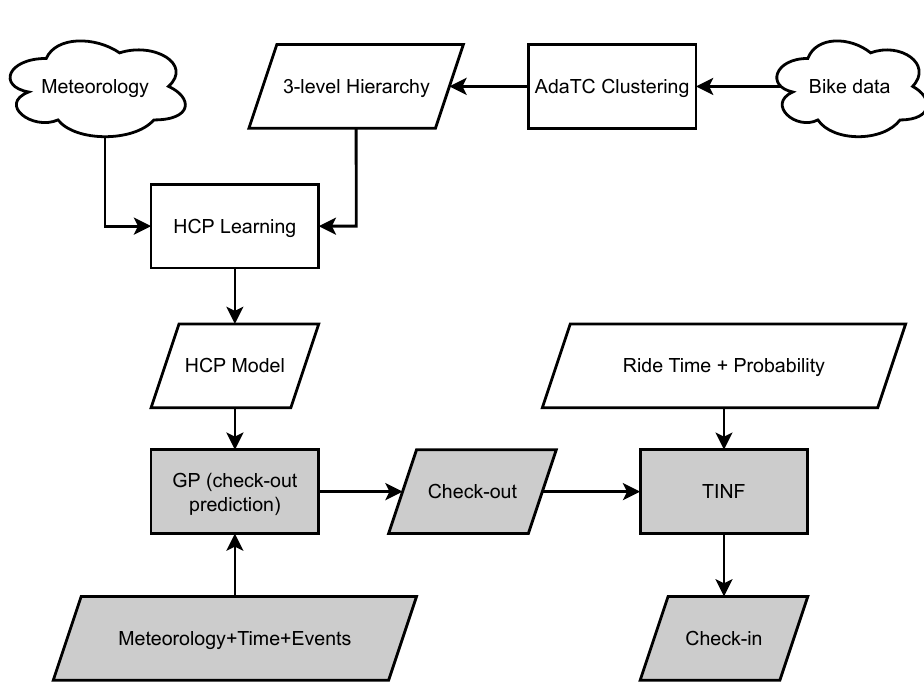
Figure 4. Prediction framework used for solving the bike-sharing system problem consists of various algorithms, which work together. The point of such a complex algorithm is to inform us ahead of time about the possibility of crowding the station and allow us to reposition bikes in advance. Bike data gathered from the whole city are firstly divided into clusters (by city segments, stations etc.) by AdaTC Clustering method. Based on this, a 3-level hierarchy is created and then meteorology data are added in order to create the Hierarchical Consistency Prediction (HCP) model. This with the combination of data about meteorology, time and particular events led to the creation of GP, the main purpose of which is to predict the check-outs of bike stations (count and time of renting a bike). With Transition based Inference (TINF) and ride time data, check-in times are inferred (count and time of returning a bike). Offline processes have a white background while online processes have greyed one